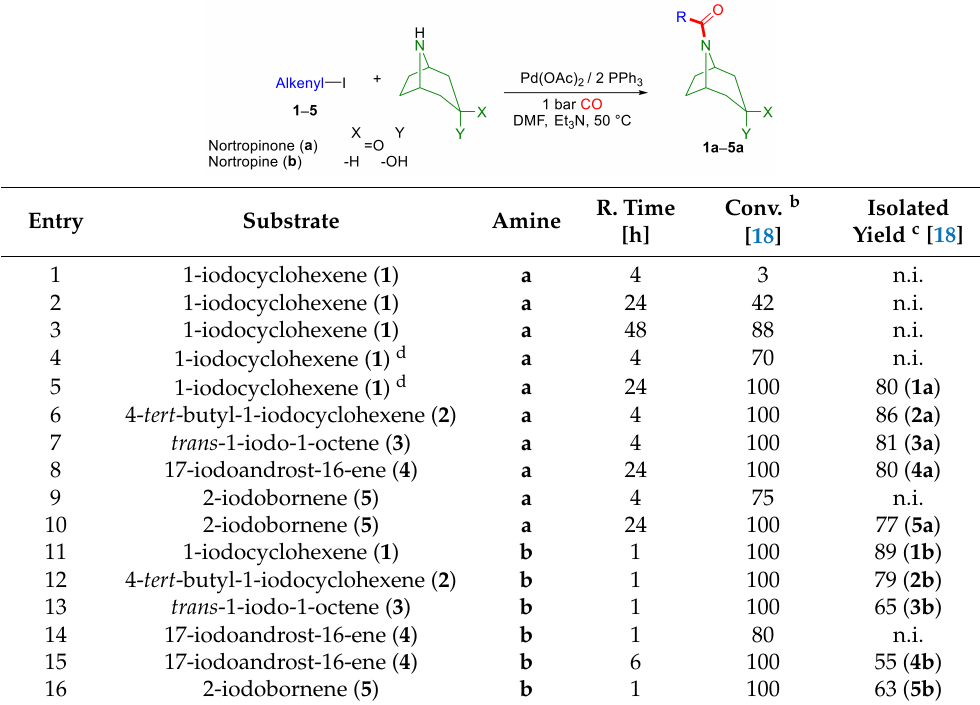
Table 1. Aminocarbonylation of nortropane-based nucleophiles ( a , b ) in the presence of iodoalkenes ( 1 – 5 ) using Pd(OAc) 2 +2 PPh 3 in situ catalyst a